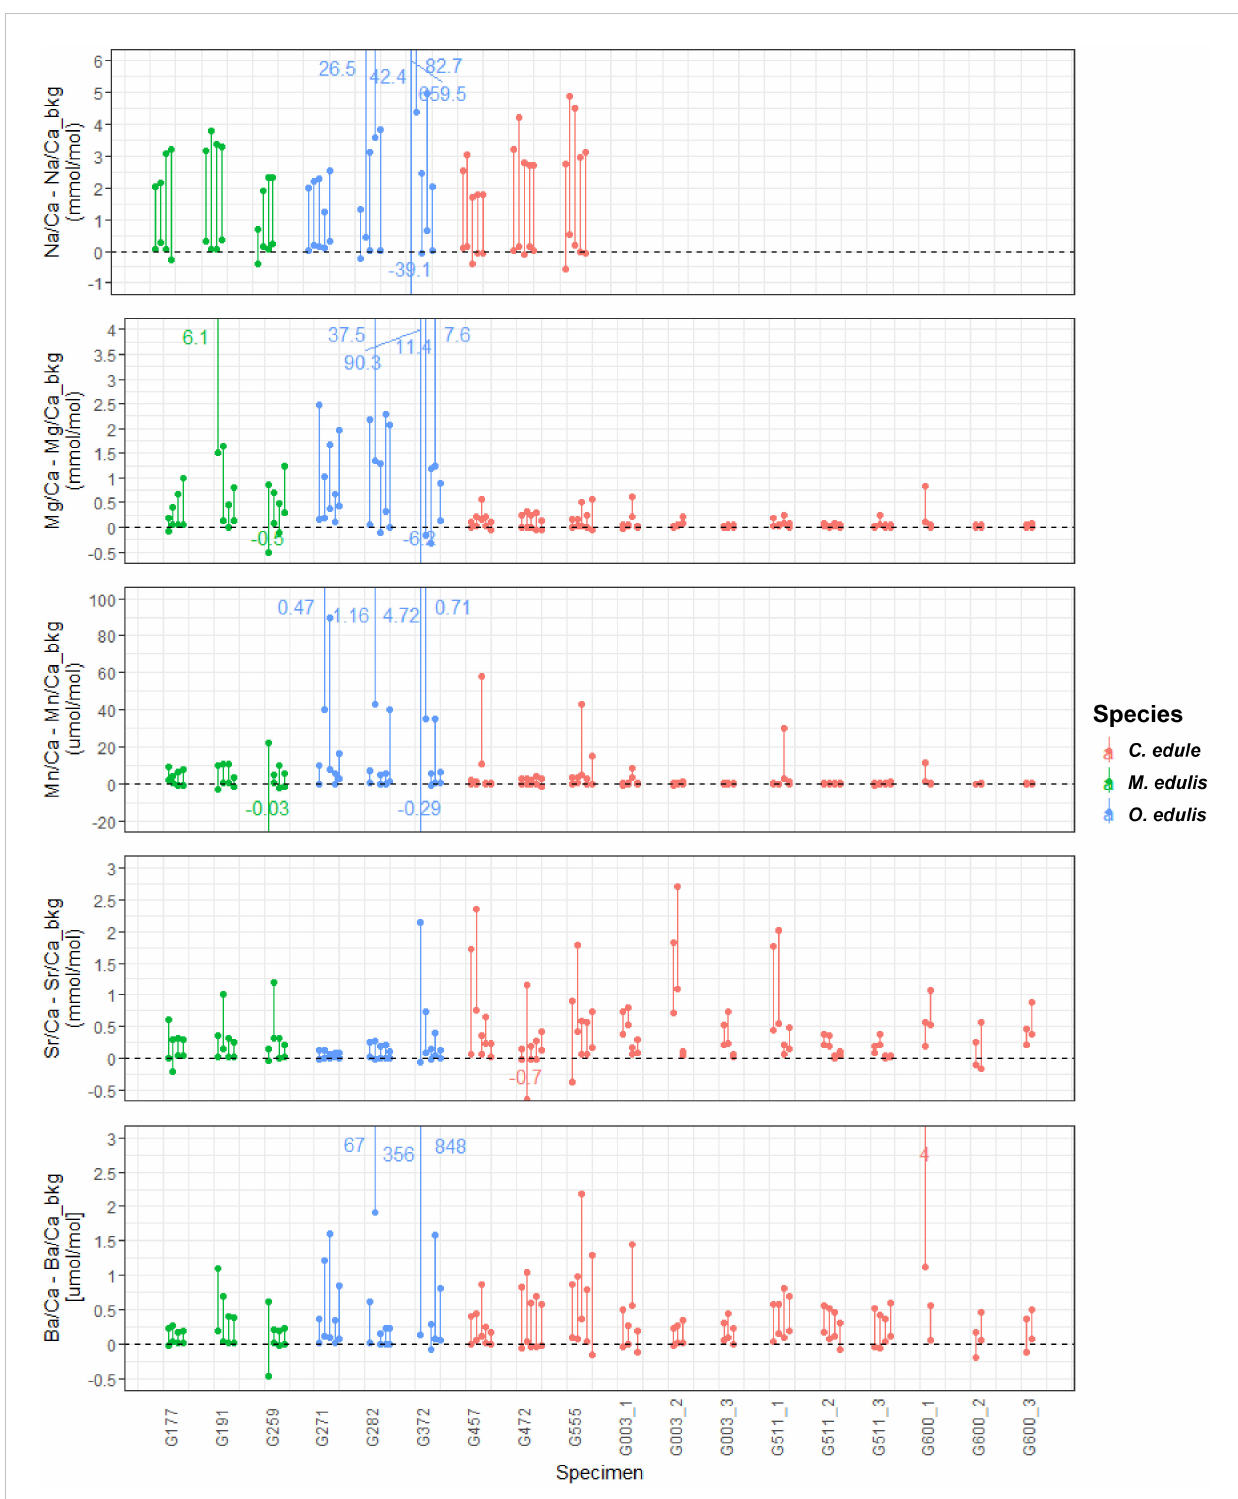
FIGURE 5 Plot showing trace element concentrations in all peaks in all specimens which lived through the entire growth experiment relative to their background values (dotted line). Lower dots show the average concentration within the peak while the higher dots (connected by a vertical line) show the average of the highest 10 measurements in the peak. Labels with subscripts (e.g. “ G003_1 ” ) indicate different pro fi les within the same specimen. Note that for specimens G003, G511 and G600 no Na concentrations were measured. Colours indicate different